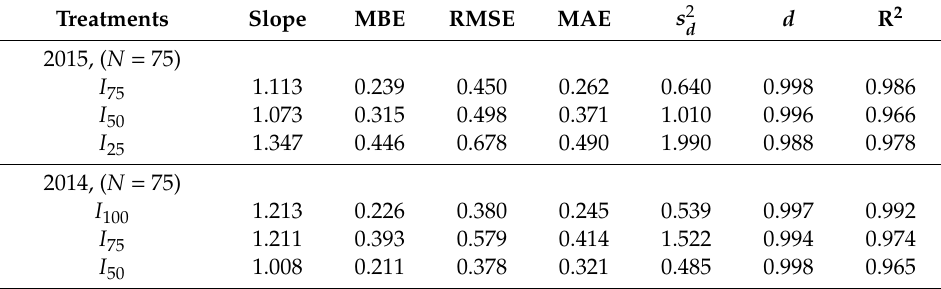
Table 3. Summary statistics of daily dry above ground biomass (D-AGB) tested against the reference method.